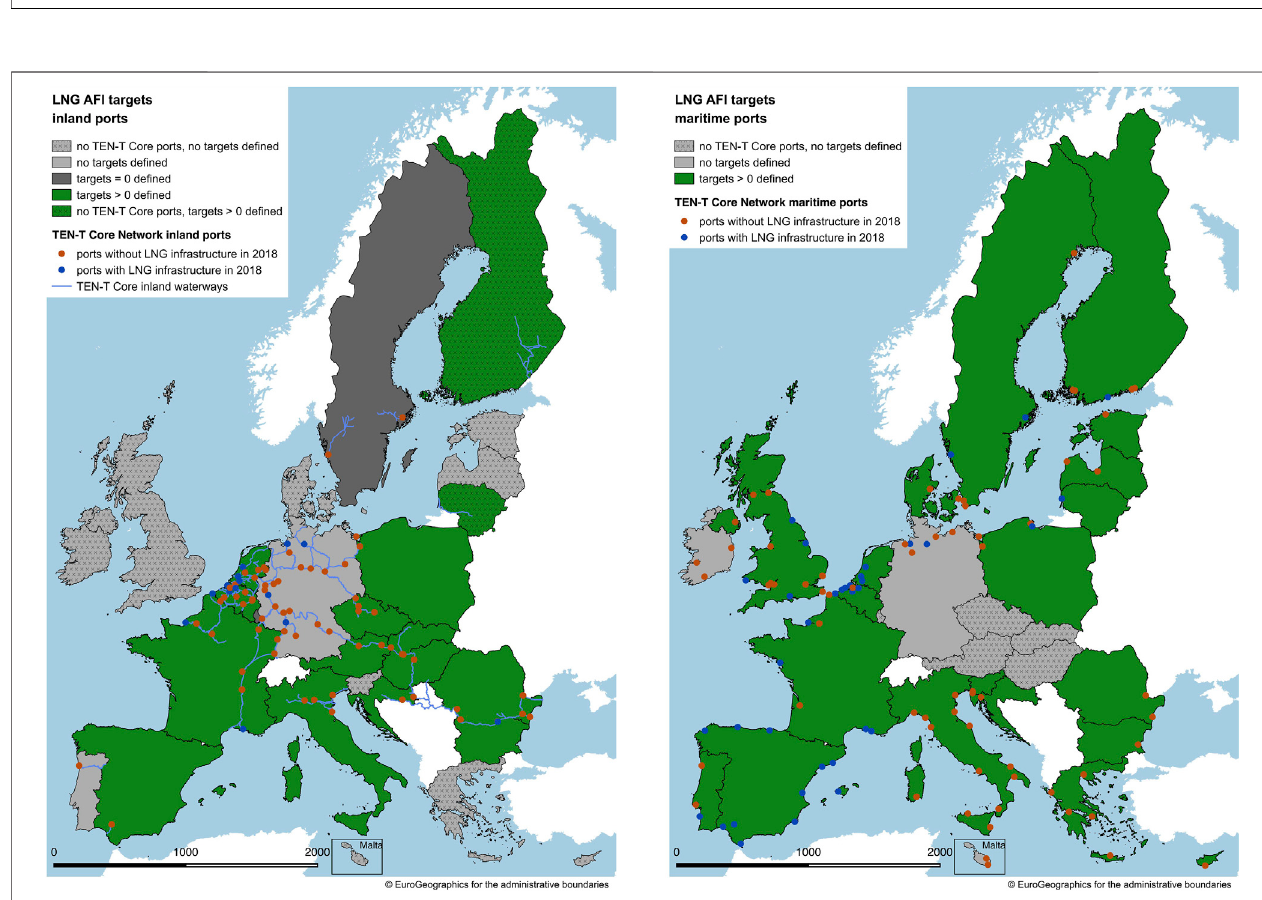
FIGURE 6 | Spatial deployment of LNG supply in TEN-T Core ports at the end of 2018 and future targets: inland in 2030 (left) and maritime in 2025 (right). Source: own work based on NIR and NPF data, (EAFO, 2022) and (GIE, 2022).